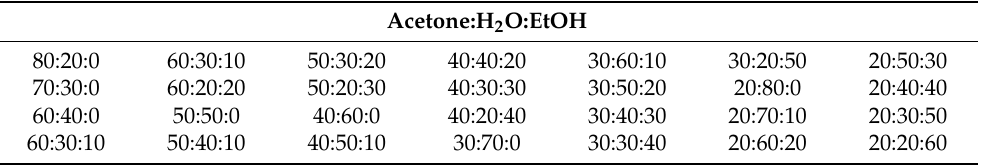
Table 1. Solvent systems trialed for solvent–liquid extraction of Pinot noir